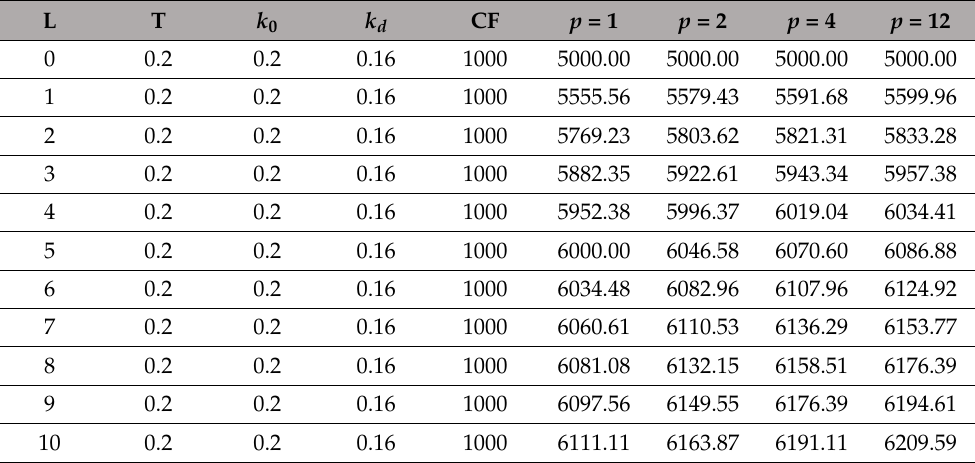
Table A5. Dependence of the company capitalization, V , on leverage level L at k d = 0.16 and different